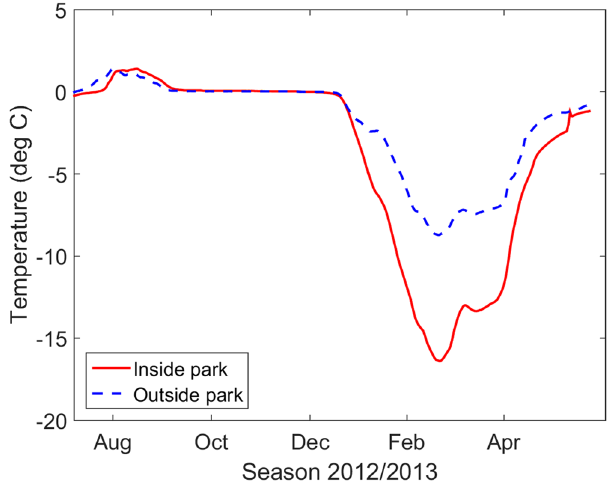
Figure 2. Comparison of soil temperature observations (°C) at 90 cm depth inside and outside the Pleistocene Park, Kolyma river lowland, Russian Far East during one year. The mean annual difference is − 1.9 °C.